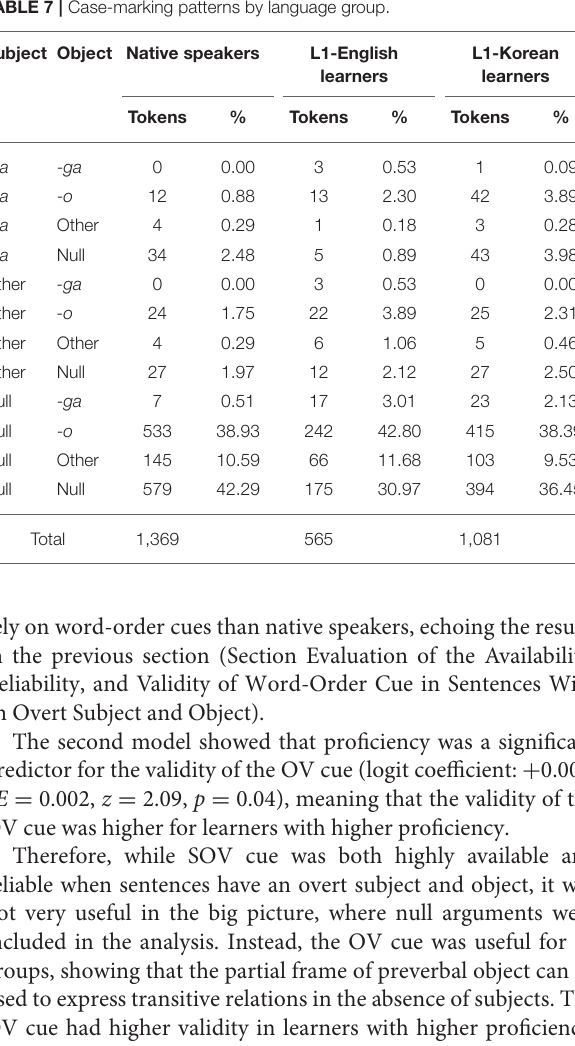
TABLE 7 | Case-marking patterns by language